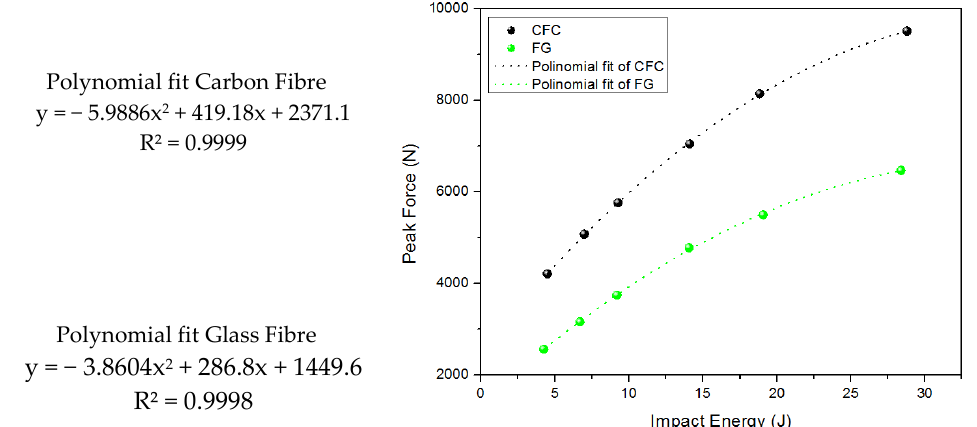
Figure 6. Energy profile with the equal energy curve.